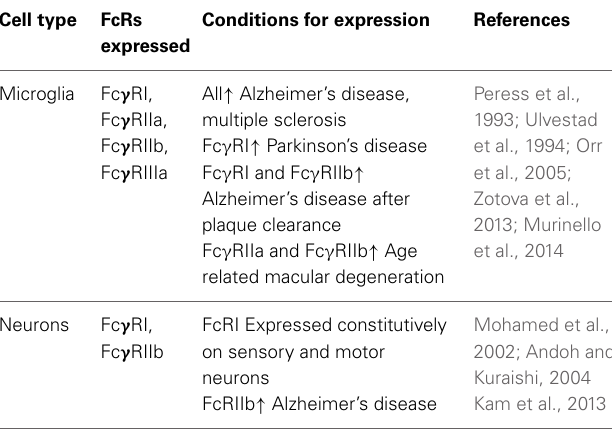
Table 1 | Expression of Fc γ Rs on murine CNS cells. Table 2 | Expression of Fc γ Rs on human CNS